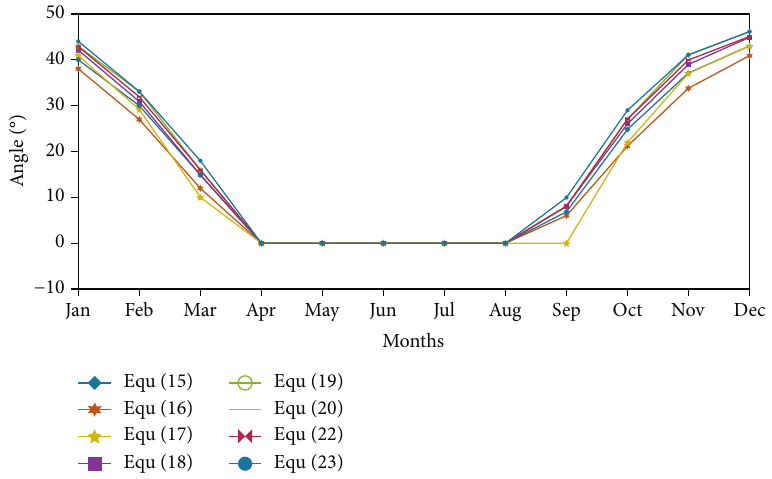
Figure 6: Monthly optimal tilt angle evaluated by isotropic and anisotropic models for Bahir Dar city.